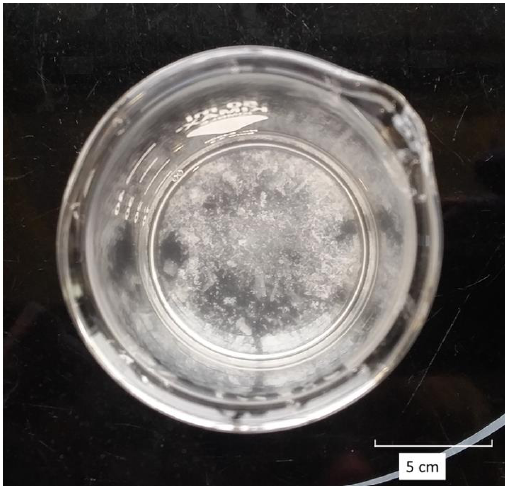
Figure 4. Typical flakes in the 5 min and 10 min samples after treatment with red mud.